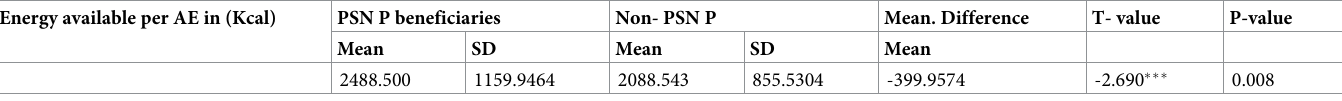
Where ��� indicated significance level at